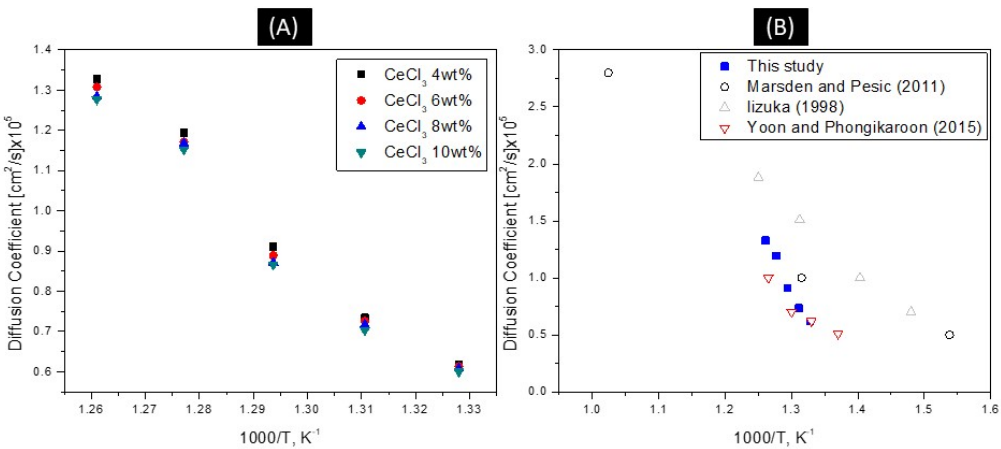
Figure 3. ( A ) Diffusion coefficient of Ce 3+ as a function of CeCl 3 concentration and temperature in LiCl-KCl. ( B ) Comparison of values from literature.